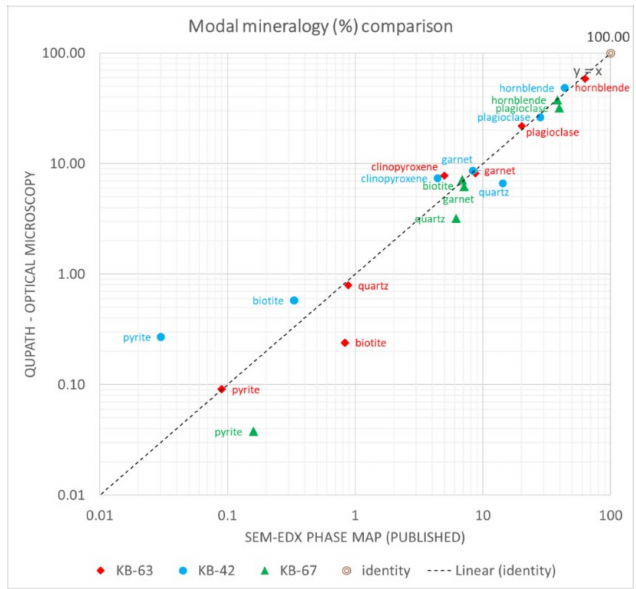
Figure 15. Modal mineralogy comparison of the segmentation from ray tracing stack and the SEM- EDX phase maps of metabasites [24]. The volume % abundance was weighted by nominal mineral densities. Note the logarithmic scale of the axes. Rock-forming minerals fit better to the 1:1 line (not the log-log scale) than accessory phases. Several phases identified in Figure 14 were omitted from the plot for